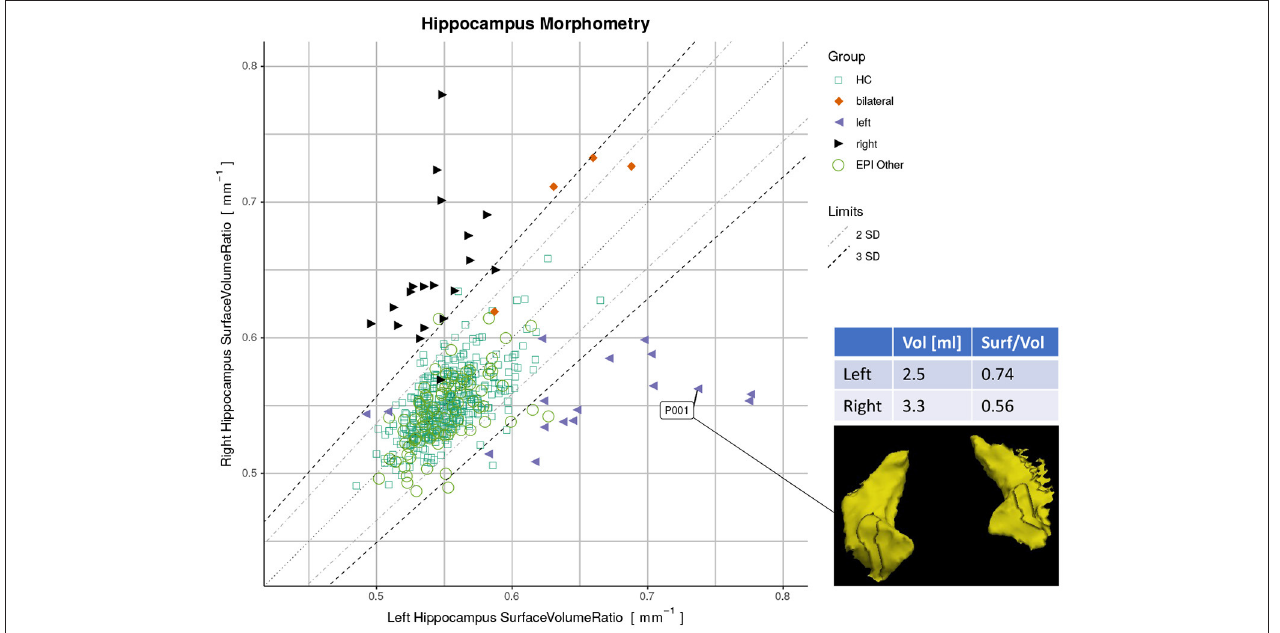
FIGURE 1 | Proposed reporting for the suggested hippocampal sclerosis (HS) biomarker by plotting the surface-to-volume ratio of both hippocampi in one datapoint. Healthy controls (HC) serve as normative data with left and right-sided HS predominantly appearing outside the limits. The highlighted case with an atrophic hippocampus on the lateral side is of a left-sided HS (appearing on the right side of the rendering in radiological orientation).